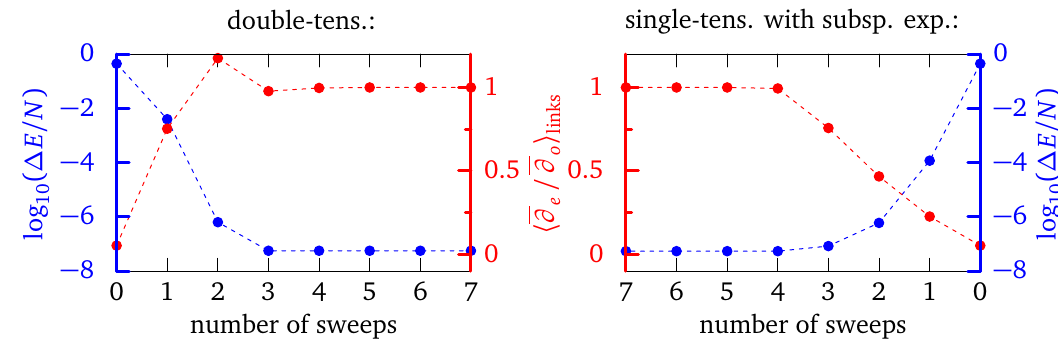
Figure 53: Comparison of link representation convergence for the double-tensor update (left) and the single-tensor update with subspace expansion (right). Plotted is the error of the ground state energy per site ∆ E / N (blue) and the over all virtual links averaged ratio of degeneracy dimensions 〈 ¯ ∂ sweep number. For both plots a system size of N = 128 and a bond dimension of D = 40 have been